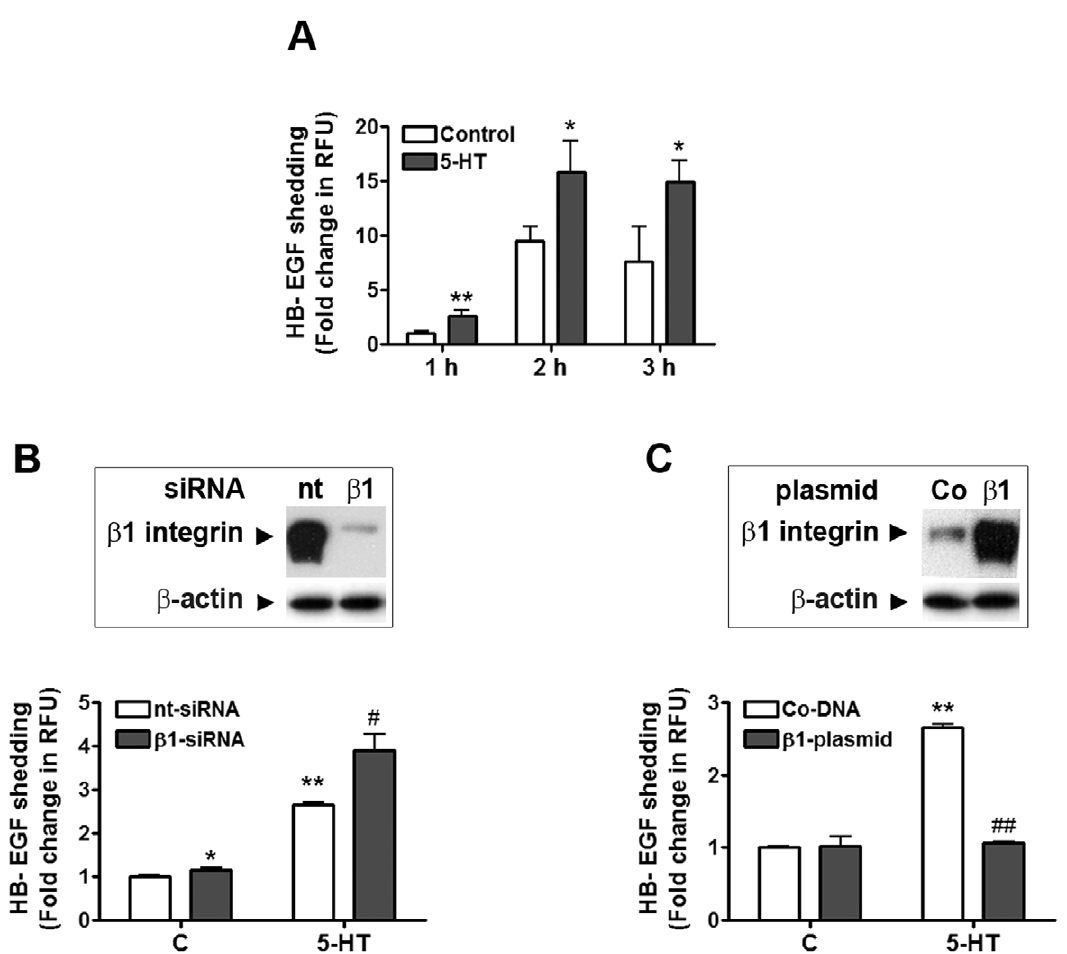
Figure 4. Integrin expression regulates ADAM17 sheddase activity. (A) Time-dependent release of alkaline phosphatase (AP)-tagged HB-EGF by unstimulated (C) and 5-HT stimulated cells. Cells were transfected with AP-HB-EGF expressing plasmid and 2 days after transfection they were stimulated with 5-HT for the indicated time. AP activity of cell supernatants was determined using Attophos substrate. Data are expressed as mean 6 S.D. of fold change in the rate of change of relative fluorescence units; *p , 0.05, **p , 0.01 vs control at same time point, n=eight experiments, three parallels/each condition. (B) b 1 integrin silencing promotes 5-HT-induced AP-HB-EGF shedding. Cells were transfected with AP- HB-EGF expression plasmid together with b 1 integrin siRNA ( b 1-siRNA) or a non-targeting (nt 2 ) siRNA. Successful silencing of b 1 integrin was confirmed by resolving the cell lysates on a 4–12% SDS-PAGE and probing for b 1 integrin and b -actin (as loading control). Two days after transfection cells were stimulated with 5-HT for 1 h and AP activity of cell supernatants was determined. (C) b 1 integrin overexpression inhibits 5-HT induced AP- HB-EGF release in mesangial cells. Cells were transfected with AP-HB-EGF and with b 1 integrin expressing plasmid ( b 1-plasmid) or control DNA (Co- DNA). Successful overexpression of b 1 integrin was confirmed by resolving the cell lysates on a 4–12% SDS-PAGE and probing for b 1 integrin and b - actin (as loading control). Two days after transfection cells were stimulated with 5-HT for 1 h and AP activity of cell supernatants was determined. Activity data are expressed as mean 6 S.D. of fold change in the rate of change of relative fluorescence units (RFU); *p , 0.05, **p , 0.01 vs unstimulated control nt-siRNA or control DNA-transfected cells; # p , 0.05 and ## p , 0.01 vs 5-HT stimulated nt-siRNA or DNA-transfected cells; n=five experiments, three parallels/each